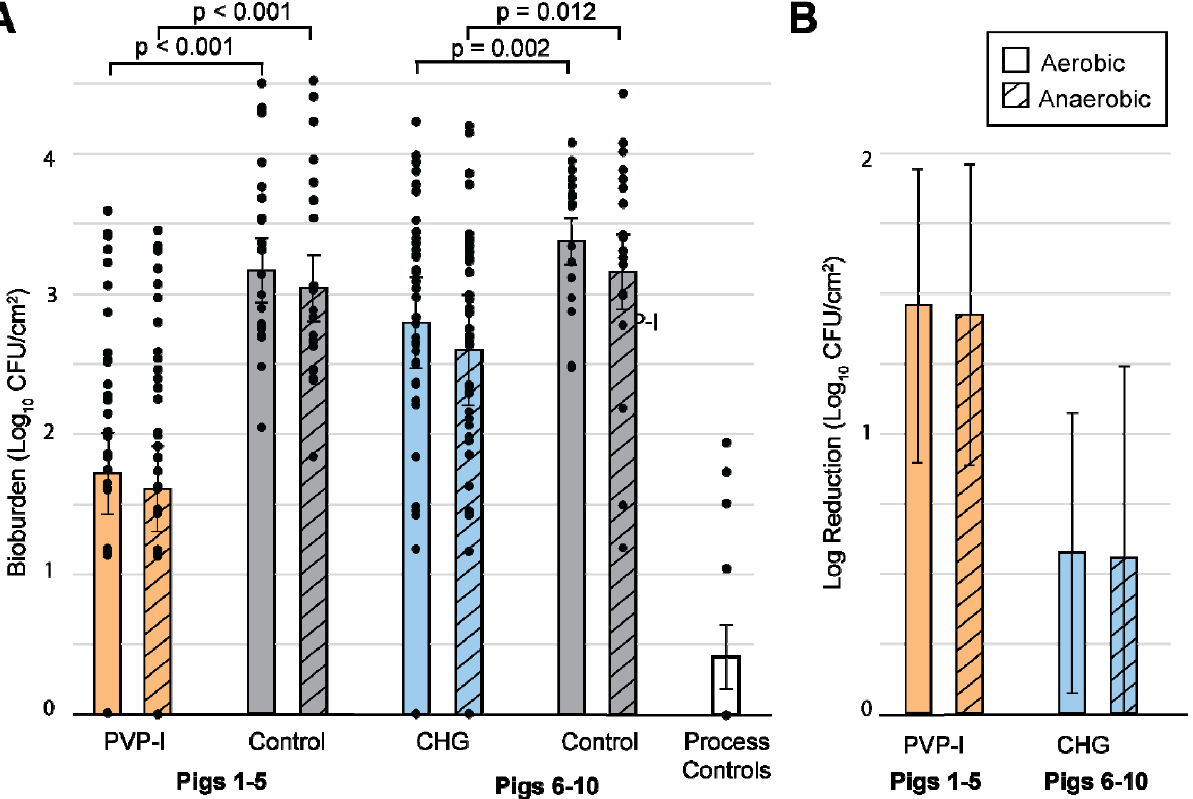
Figure 5. Bioburden for each PSP and the corresponding controls. Each bar is the average of each test condition. The points shown along each bar represent all individual tissue samples pooled together. Error bars are the standard error from the mixed regression model to represent clustered data. A solid bar indicates aerobic condition while hatching indicates anaerobic condition. ( A ) shows bioburden in log 10 CFU/cm 2 with an axis of 0–4, while ( B ) shows log reduction with an axis of 0–2. In each chart, the pig numbers corresponding to the respective treatments are shown. A selection of p values is listed above the brackets indicating the data that were compared. In both aerobic and anaerobic conditions, comparing PVP-I-scrubbed tissue with controls resulted in a p value of <0.001. Comparing CHG with the corresponding controls yielded p values of 0.002 and 0.012 for aerobic and anaerobic conditions, respectively.